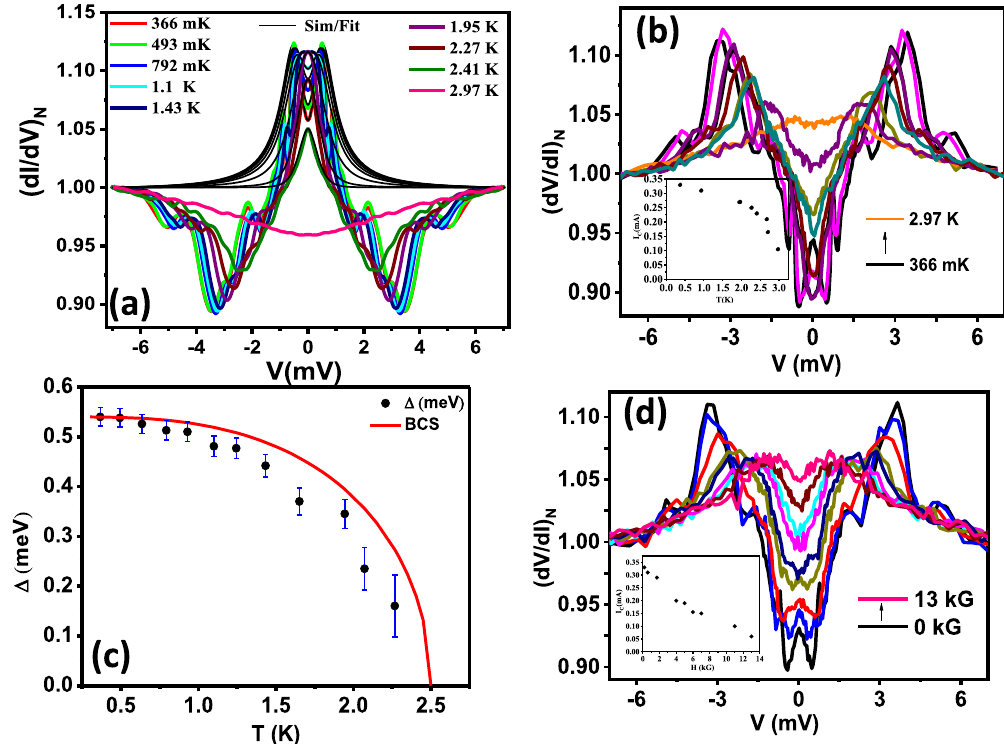
Figure 3. ( a ) Temperature dependence coloured dots) of normalized (dI/dV)_N vs V along with the best theoretical BTK fits (solid black lines) of the spectra shown in Fig. 2a. ( b ) Temperature dependence of the spectrum shown in Fig. 2a. The inset shows temperature dependence of the current corresponding to the peaks ( I c ) extracted from the data. ( c ) (cid:31) vs. T plot extracted from ( a ). The Red line shows the expected BCS line while the black dots show the experimental data ( d ) Magnetic field ( H ) dependence of the spectrum shown in Fig. 2a. The inset shows magnetic field dependence of the current corresponding to the peaks ( I c ) extracted from the